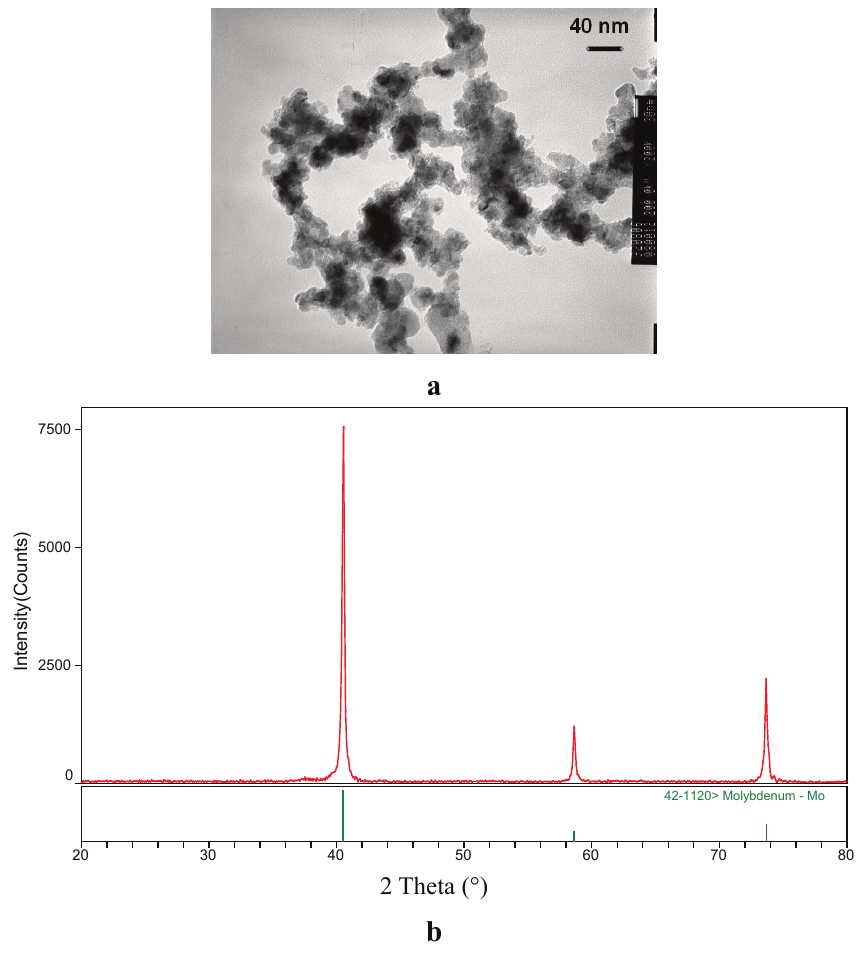
5. ( a ) Transmission electron micrograph of Molybdenum nanopowders; ( b ) X-ray diffraction pattern of Molybdenum